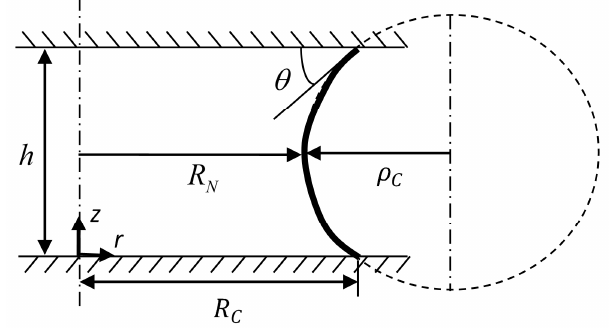
Figure 4. Schematic of the liquid bridge represented by the thick black line approximated with toroidal geometry.